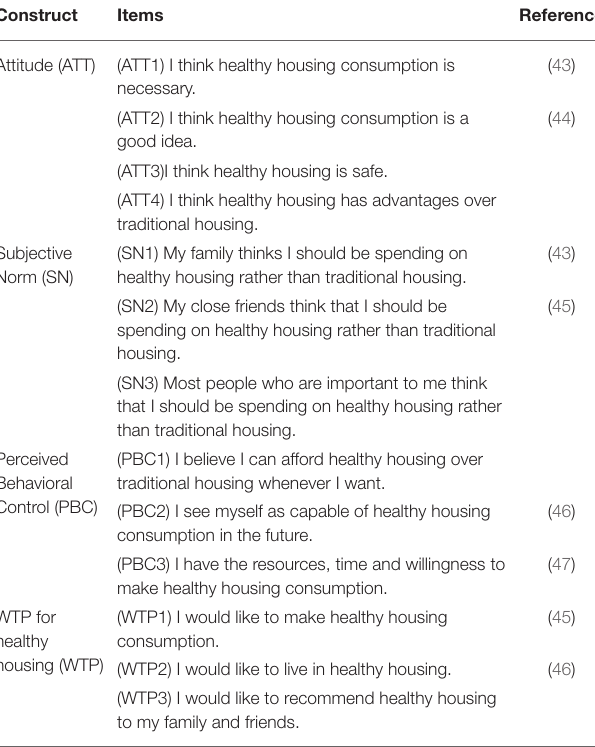
TABLE 1 | List of measurement items. TABLE 2 | Demographic characteristics of the participants ( N